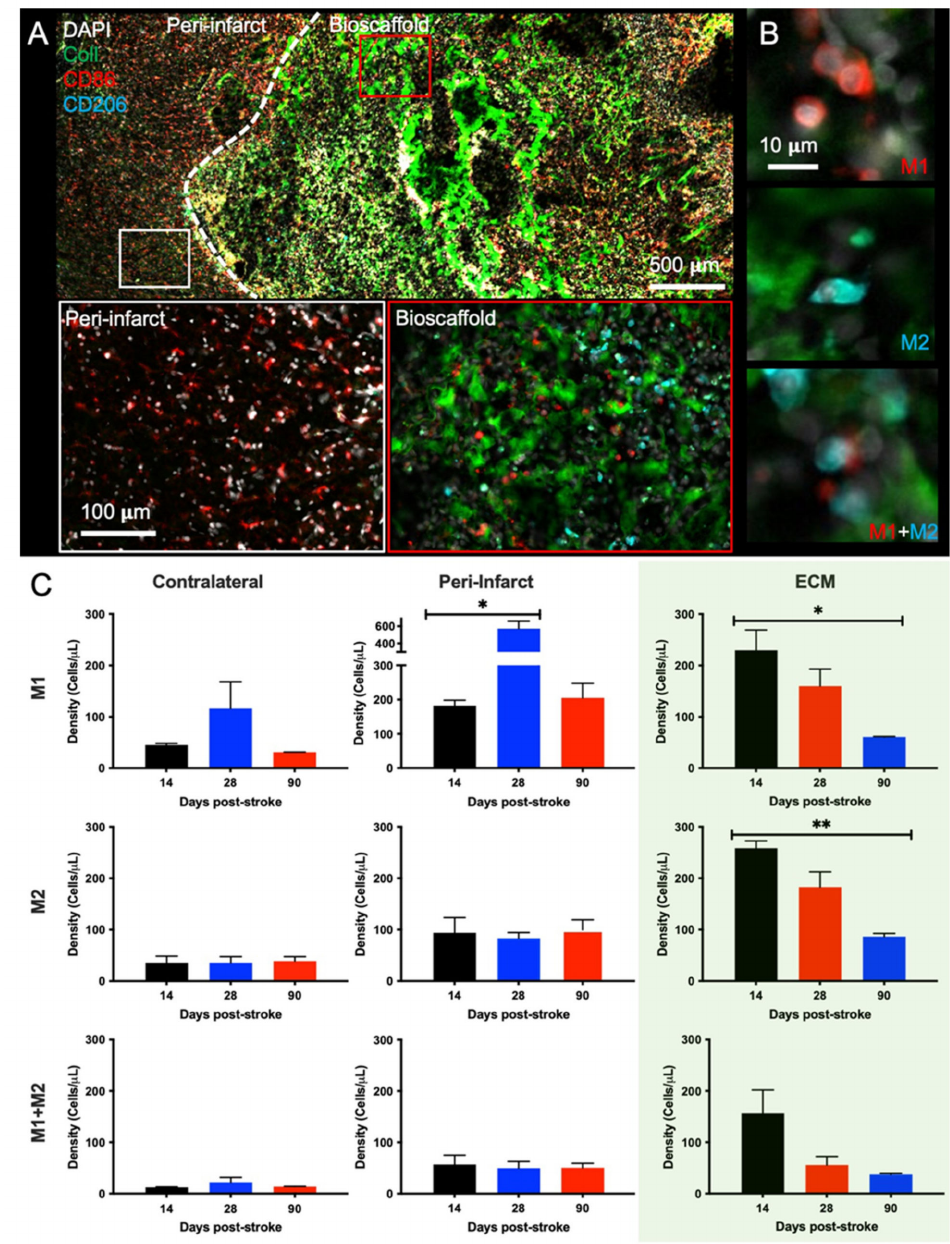
Figure 6. Phenotypic characterization of invading immune cells in ECM hydrogel. ( A ) An invasion of M1- (CD86+) and M2-like (CD206+) macrophages is evident both within the ECM hydrogel and the surrounding peri-infarct region (28-days post-stroke condition). In the peri-infarct region, there is a much larger proportion of M1- to M2-like macrophages compared to within the bioscaffold. ( B ) Within the bioscaffold, M1-like and M2-like polarization of macrophages was evident, with some cells expressing both markers. ( C ) Quantification of the M1/M2 polarization revealed an almost 1:1 ratio of M1- to M2-like macrophages across all time points within the bioscaffold. In the peri-infarct regions, there was a high concentration of M1-like macrophages, especially the 28-days post-stroke, while M2 and M1+M2 macrophage levels remained low. In the contralateral hemisphere, very few macrophages were detected. (* p < 0.05; ** p <